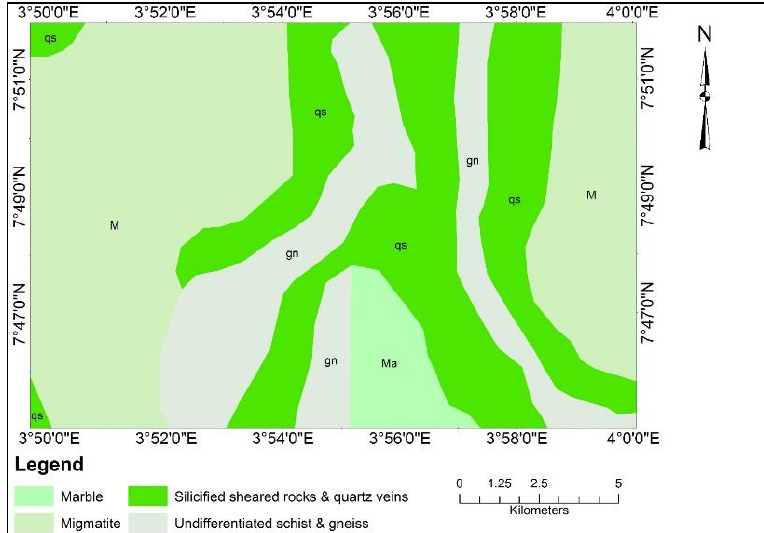
Figure 2: Geological map of